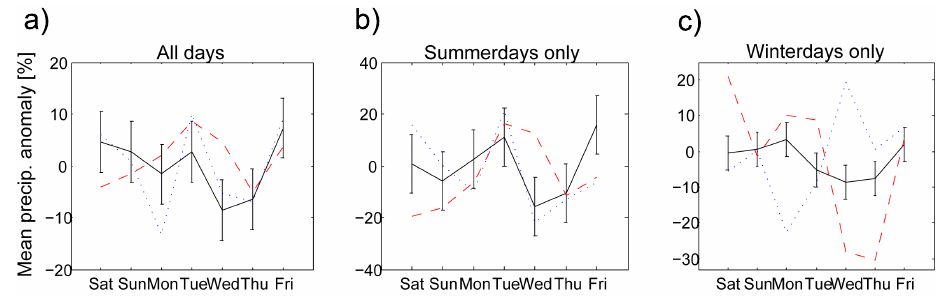
Fig. 6. Weekly cycles of regional mean (average of the 30 stations in the Black Triangle) precipitation amount anomaly, for the entire 1983– 2008 period (solid black line), the more polluted 1983–1987 period (red dashed line) and the cleaner 2004–2008 period (blue dotted line) for